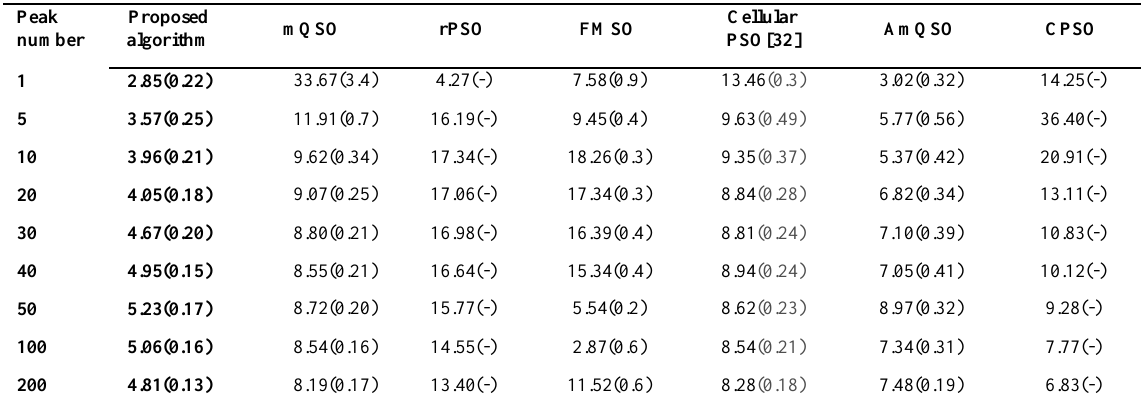
Table 3. Average offline error for different algorithms on MPB problem with different numbers of peaks and frequency